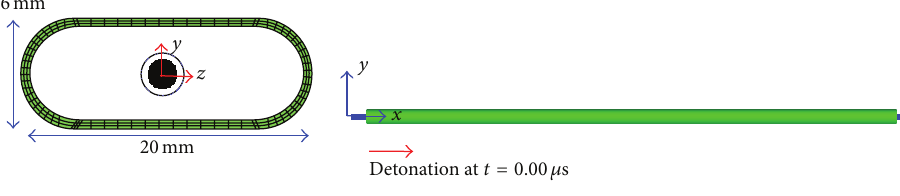
Figure 10: Three-dimensional expanding tube.